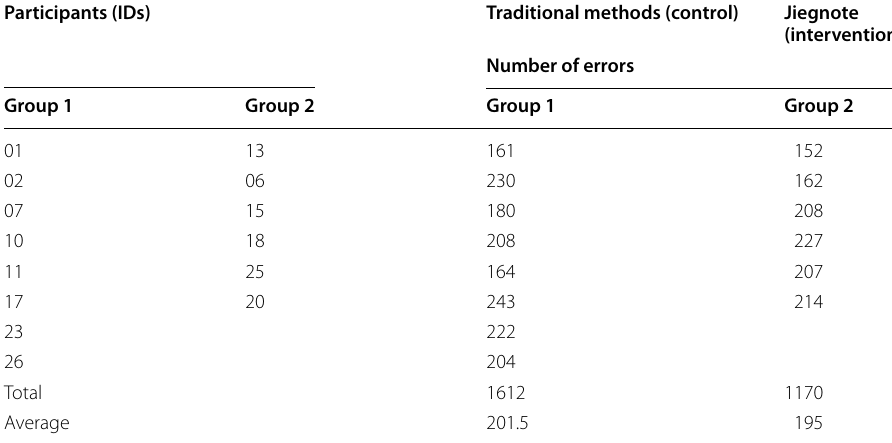
Table 3 Transcription errors committed during cases; A, and B